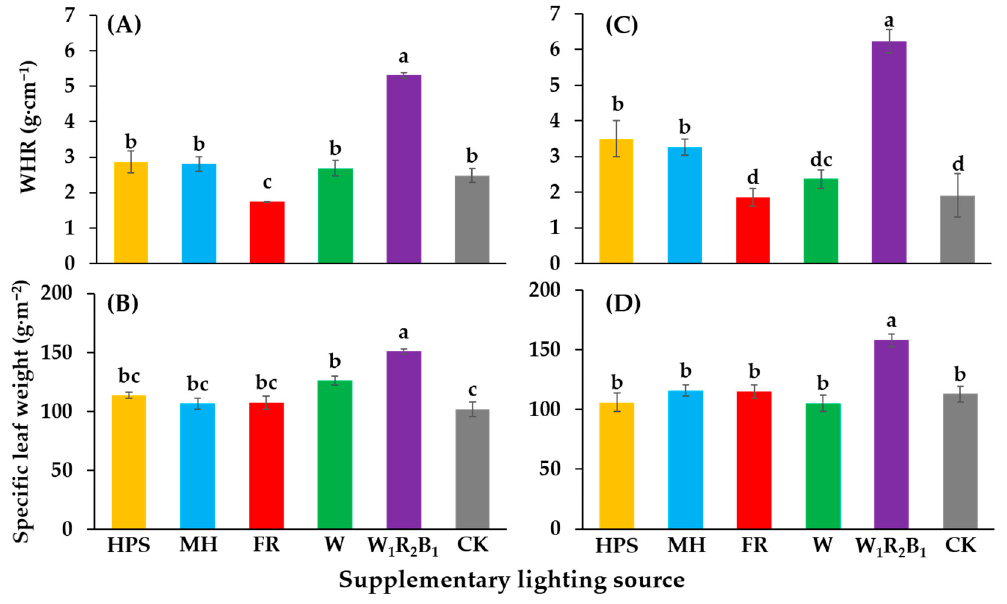
Figure 5. Effects of supplementary lighting on the WHR (scion dry weight to height ratio) and specific leaf weight of two tomato cultivars Super Sunload ( A , B ) and Super Dotaerang ( C , D ). The error bars represent the stand error ( n = 9). Different letters indicate differences between treatments (ANOVA and Duncan’s test, p ≤ 0.05).